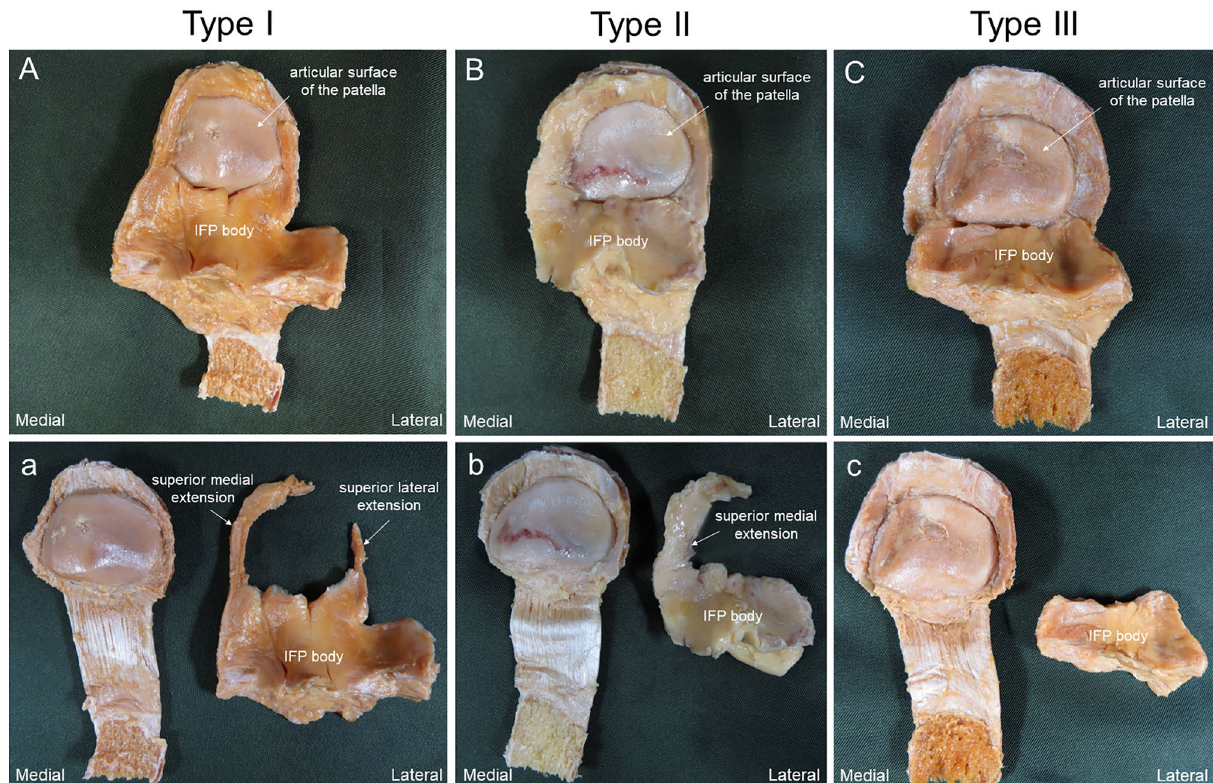
Figure 5. Classification of the IFP. ( A ) Type I: IFP proximal located on the medial side (superior medial extension) and lateral side (superior lateral extension) of the patella. ( B ) Type II: only IFP proximal located on the medial side (superior medial extension) of the patella. ( C ) Type III: absence of IFP proximal located on the medial and lateral sides of the patella. ( a – c ) IFP removed from the patella. IFP infrapatellar fat pad.